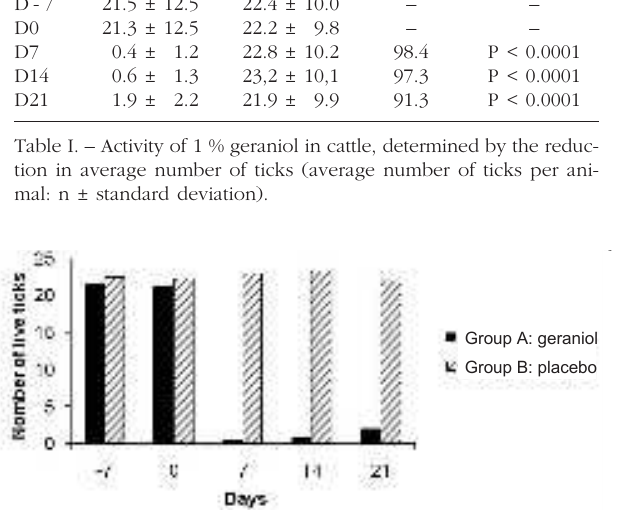
Fig. 1. – Evolution of tick infestations in sprayed and control groups, shown by number of ticks per animal. Only live ticks found on ani- mals are reported on the